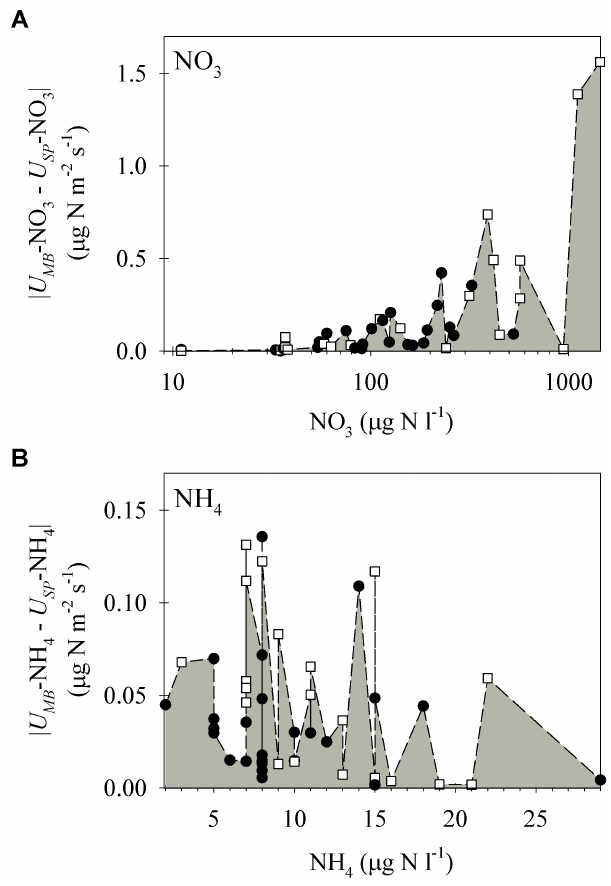
Fig. 2. Absolute differences between the net uptake rates estimated with the mass balance approach ( U MB ) and the spiralling approach ( U SP ) sorted as a function of average stream N concentration for (A) NO 3 and (B) NH 4 . White squares and black circles correspond to values from Fuirosos ( n = 20) and Santa Fe ( n = 25) streams, respectively. Note logarithmic scale on the x-axis of (A)